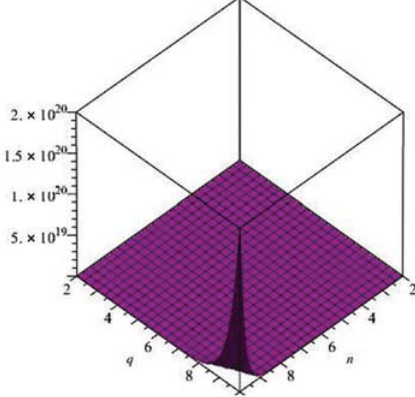
Figure 2: Plot of the average eccentricity.